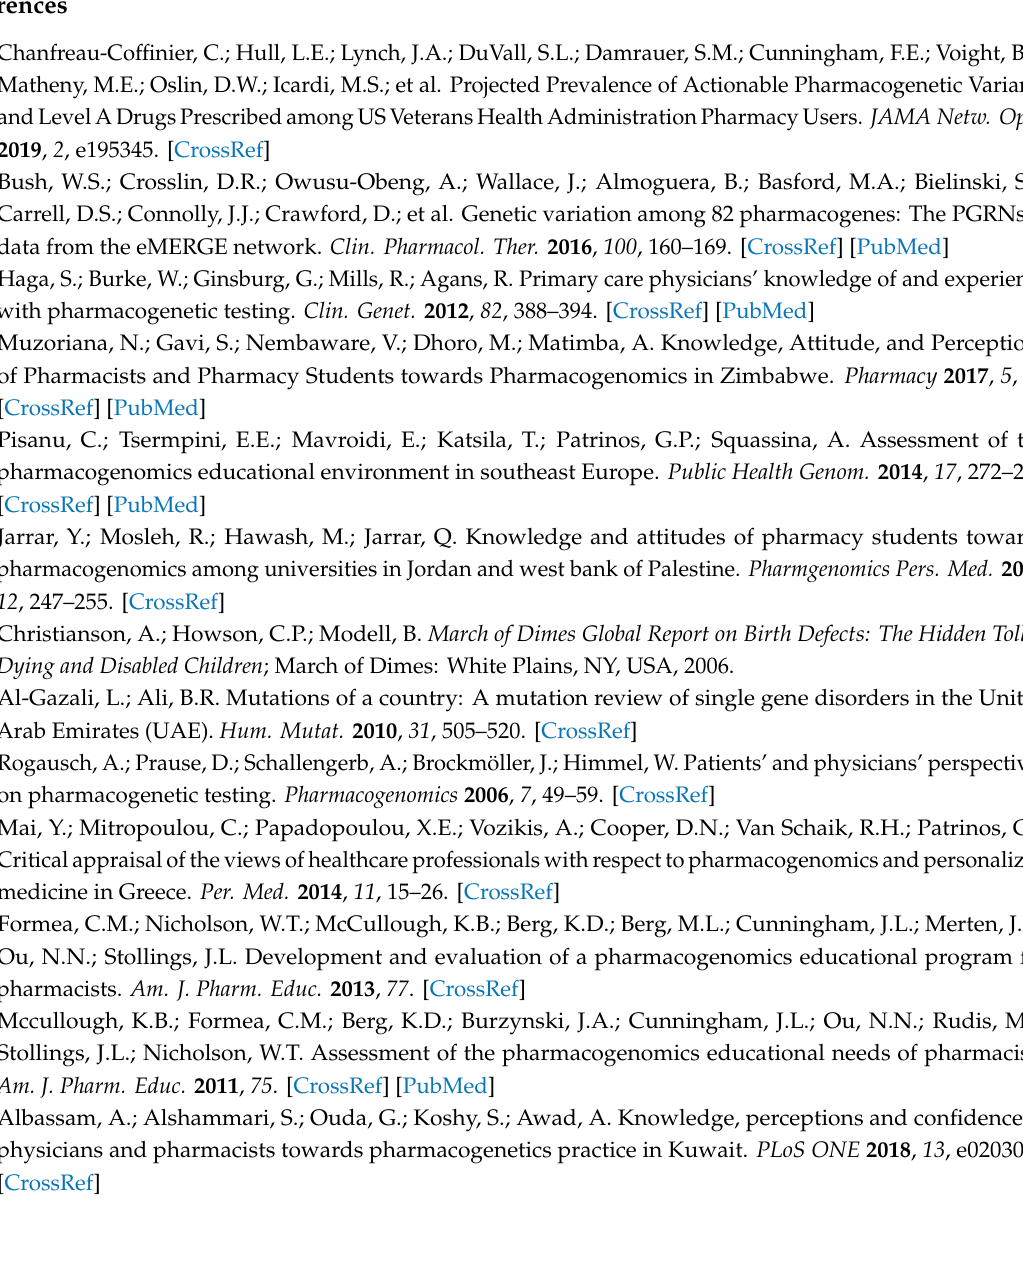
Figure S1a: Attitudes on genetic testing ( N = 388), Figure S1b: Concerns and ethics on PGX and genetic testing ( N =